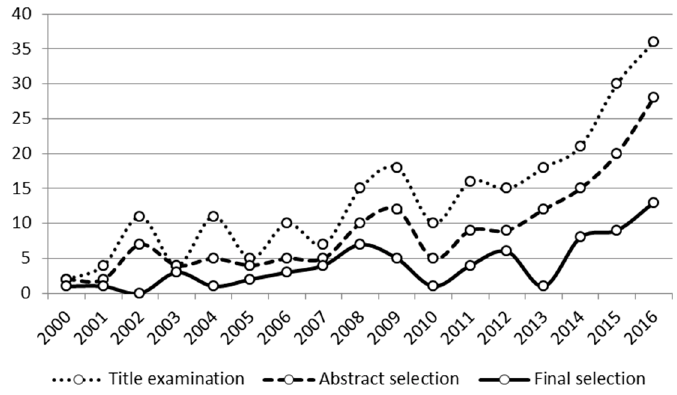
Figure 2. Number of published papers per year at different review process stage.